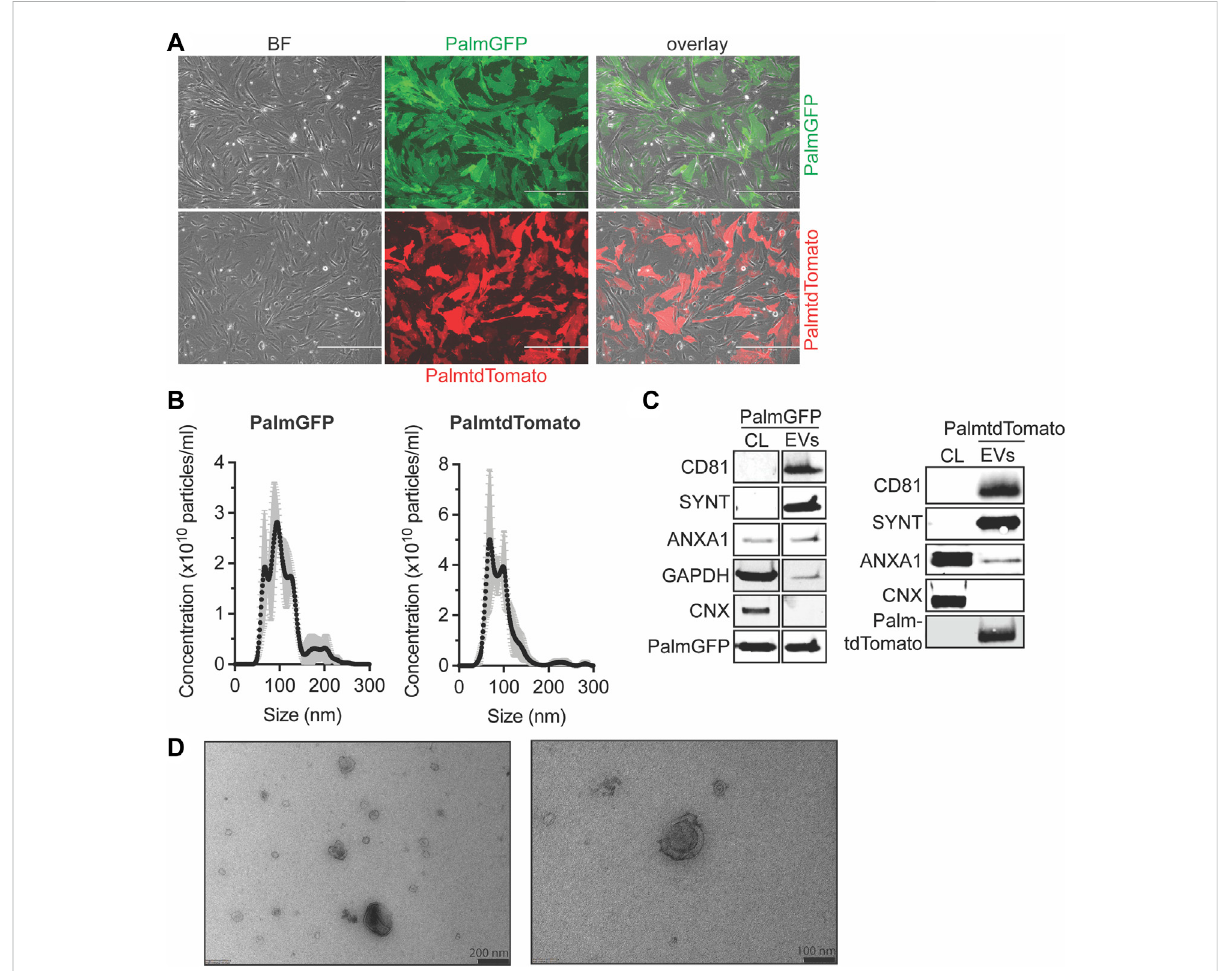
FIGURE 1 Characterization of PalmGFP- and PalmtdTomato-labeled EVs derived from CPCs. (A) Fluorescent microscopy pictures of CPC cells stably expressing (top) PalmGFP or (bottom) PalmtdTomato. Scale bars represent 400 µm. (B) Representative NTA plots showing the size distribution and particle concentration of EVs after SEC isolation of conditioned medium derived from PalmGFP + - and PalmtdTomato + CPCs. (C) Western blot analysis showing the presence of CD81, Syntenin-1 (SYNT), AnnexinA1 (ANXA1), GAPDH, PalmGFP and/or PalmtdTomato, and absence of Calnexin(CNX)in(left)PalmGFP + -and(right)PalmtdTomato + EVs.Celllysates(CL)derivedfrom(left)PalmGFP + or(right)(TdTomato-negative)CPCs were included as control. Uncut blots are included in Supplementary Figure S10. (D) Representative TEM images of PalmGFP + EVs at two different magni fi